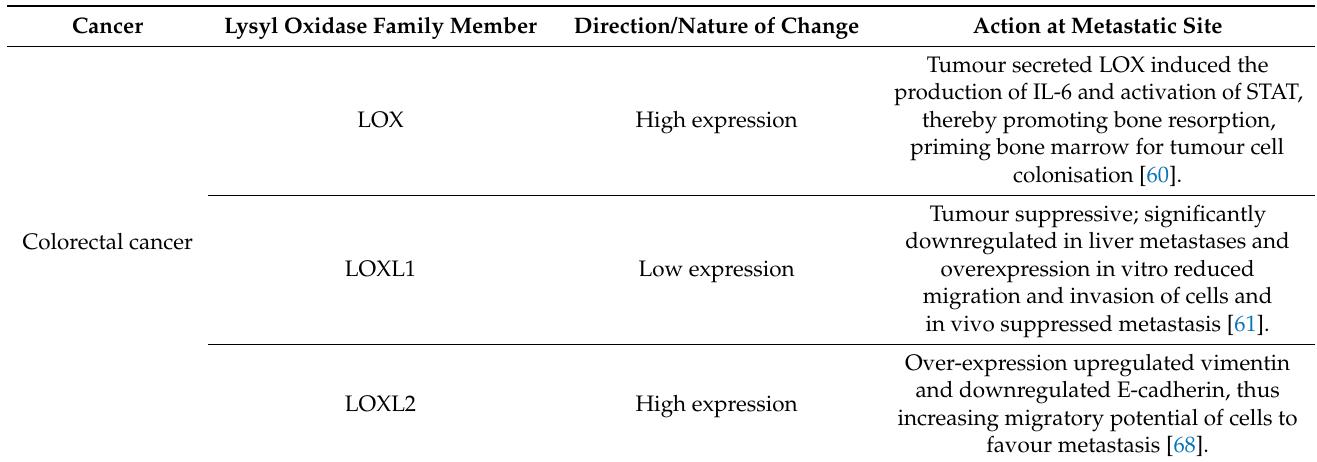
Table 2. Reported LOX family member involvement at the metastatic